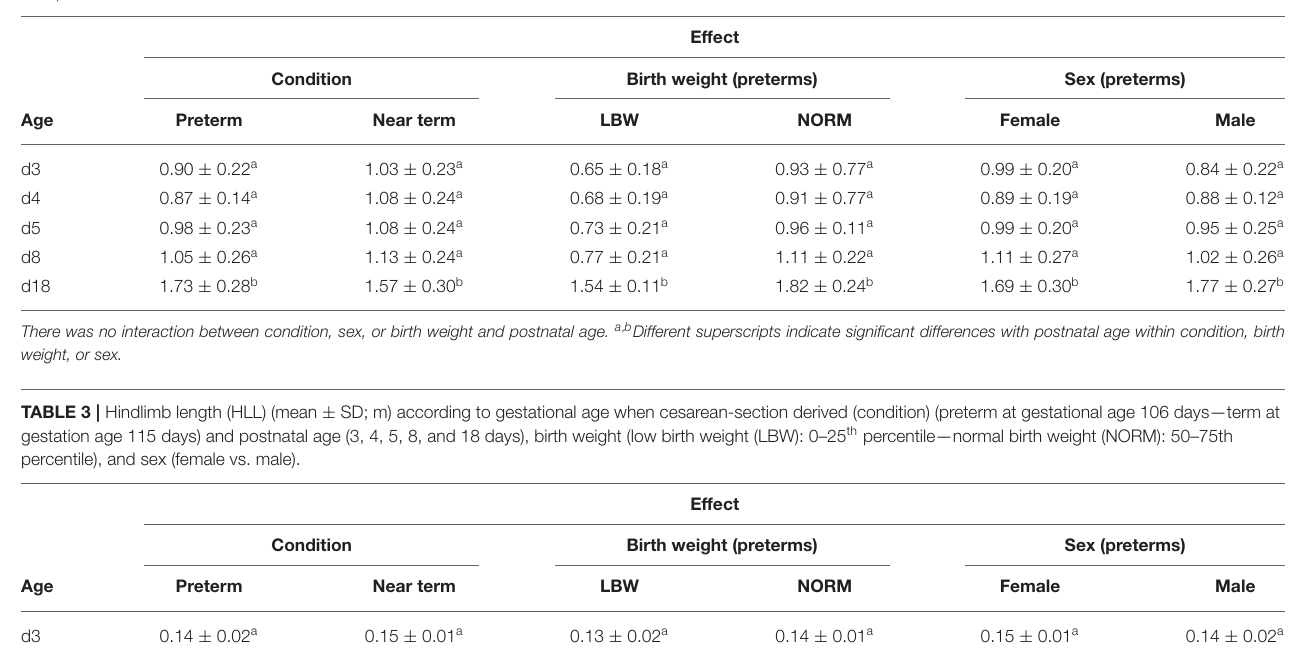
TABLE 2 | Body weight (mean SD; kg) according to gestational age at birth (condition) (preterm at gestational age 106 days—term at gestation age 115 days) and ± postnatal age (3, 4, 5, 8, and 18 days), birth weight (low birth weight (LBW): 0–25th percentile—normal birth weight (NORM): 50–75th percentile), and sex (female vs.